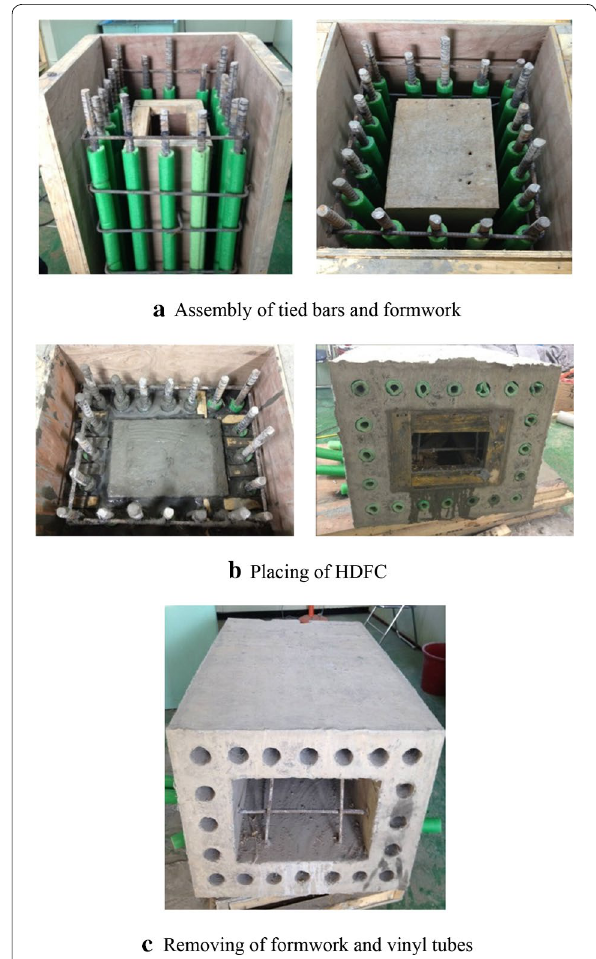
Fig. 4 Precasting process for the HDFC